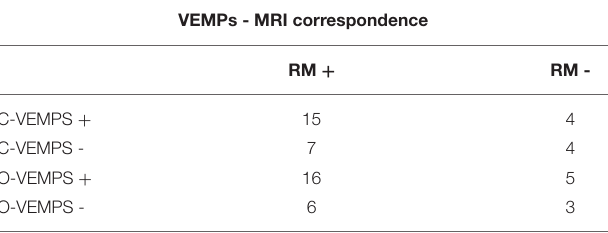
TABLE 4 | Ratio between positive and negative patients on MRI and patients with and subjects with absent or reduced evocability of VEMPs ( p CVEMPs = 0.3, p OVEMPs = 0.5).